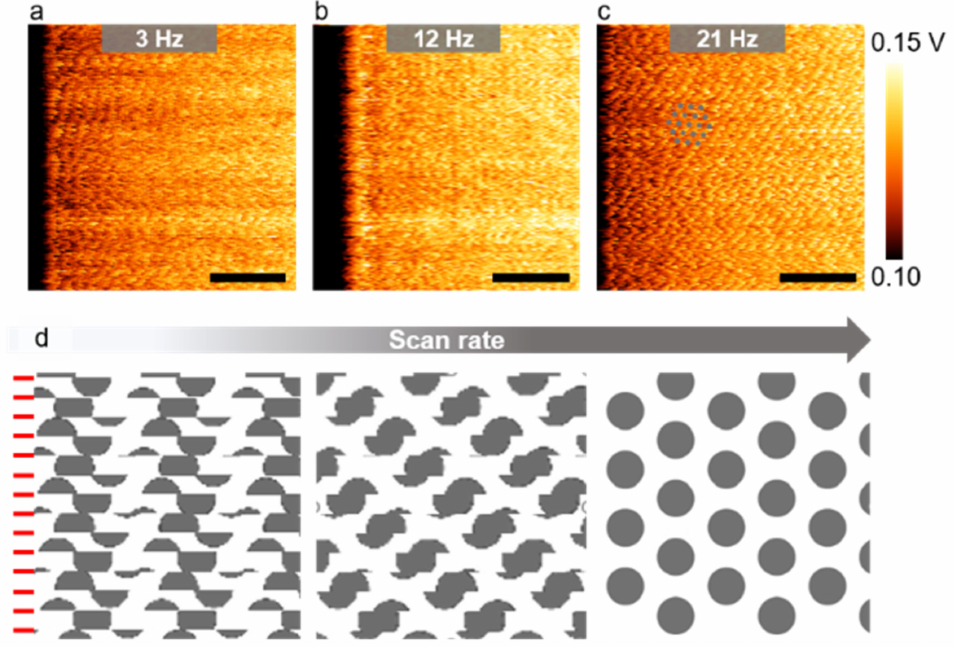
Figure 3. Scan rate-dependent atomic lattice images (color range adjusted). ( a – c ) LFM raw images of MoS 2 acquired at various scan rates. Grey dots are a guide for the eye and correspond to the centers of the MoS 2 hexagons. All scale bars are calibrated and correspond to 2 nm; ( d ) schematic representations of the LFM images as a function of the scan rate, assuming a constant drift velocity. The red lines mark horizontal scan lines. Image distortion is reduced with an increasing scan